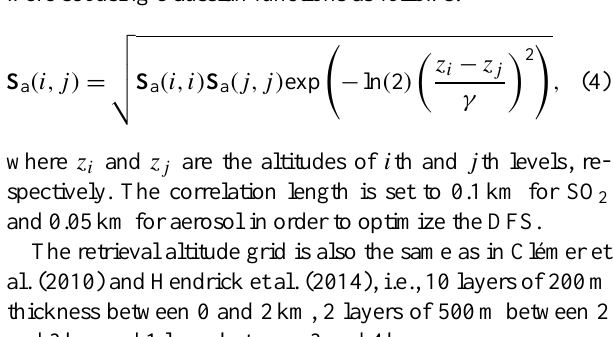
Table 2. Error budget of retrieved SO 2 concentration (0–200m) and